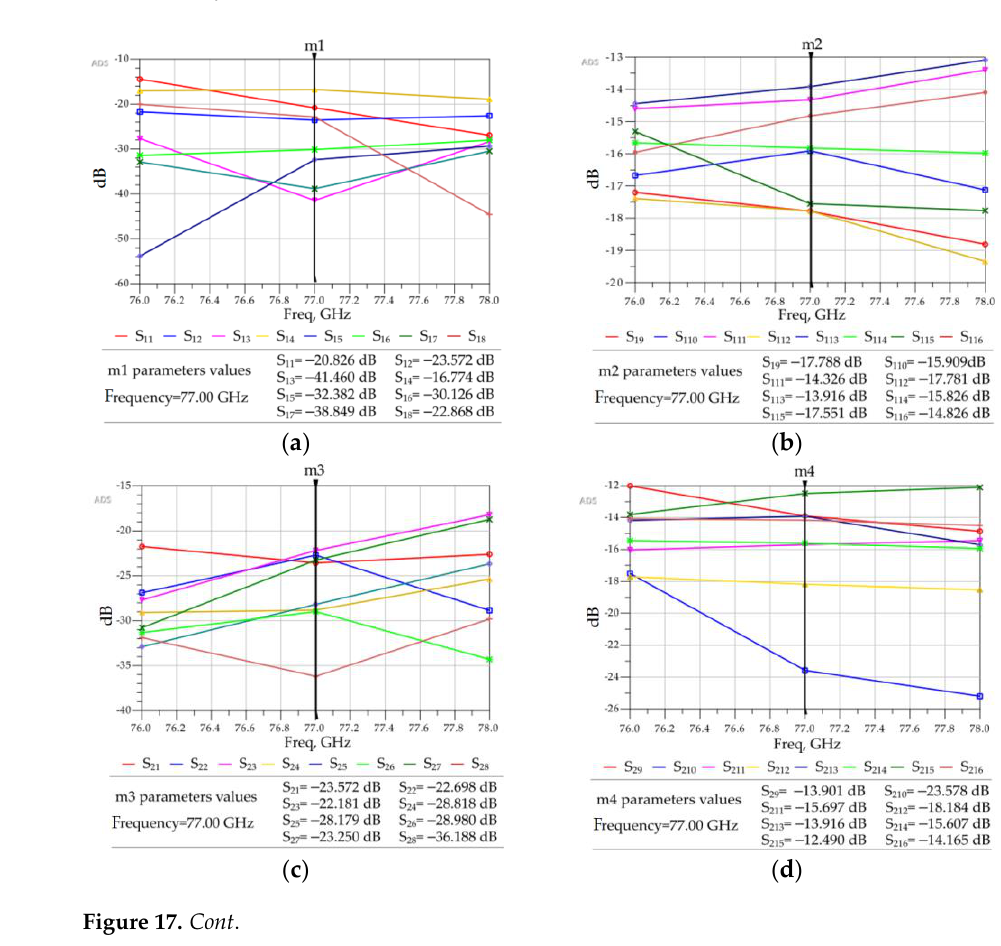
Figure 16. Layout of the 8 × 8 Butler matrix in ADS.